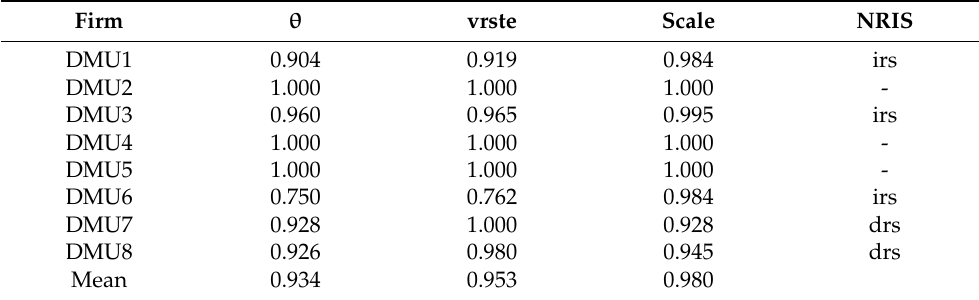
Table 6. The results of input and output validity based on DEA model.